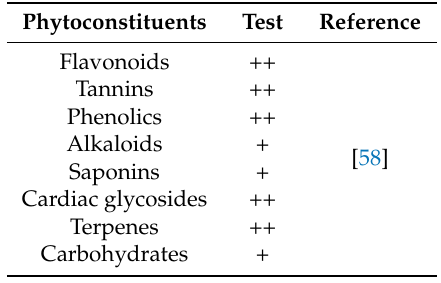
Table 4. Phytochemical screening of methanolic extract of G. kurroo Royle